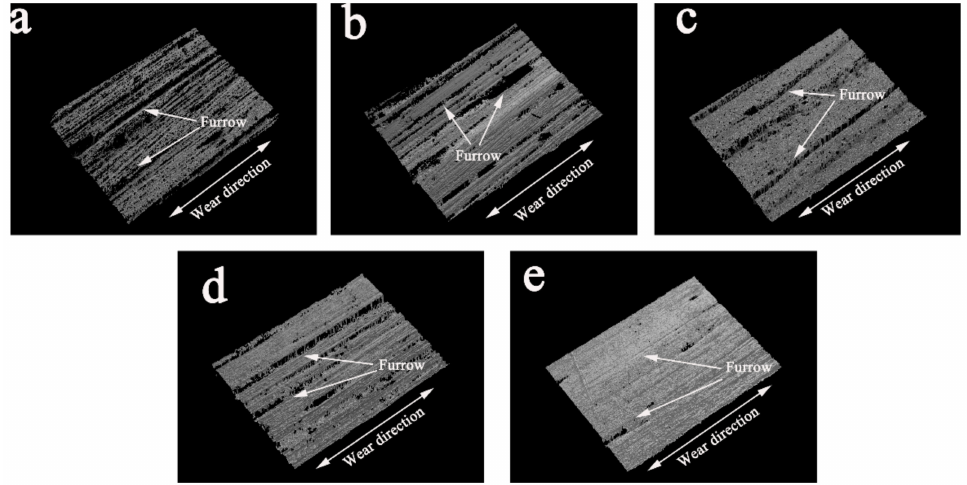
Figure 15. Wear morphology of the untreated samples: ( a ) A1, ( b ) A2, ( c ) A3, ( d ) A4, and ( e )